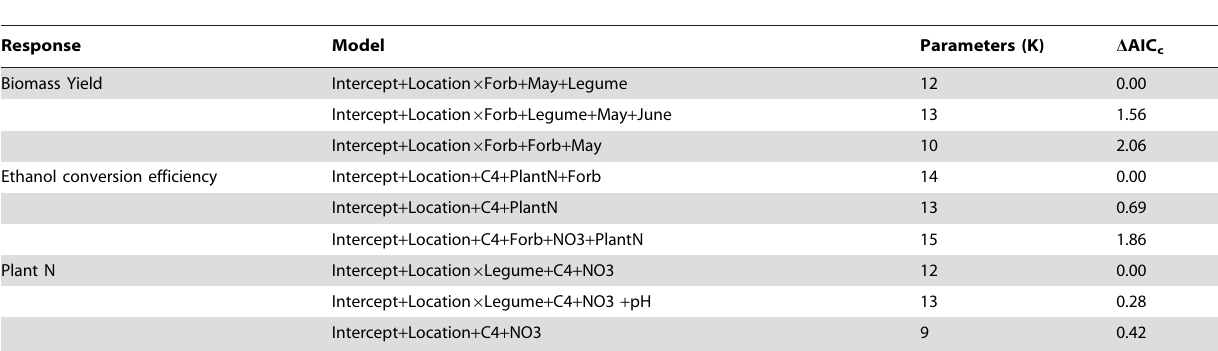
Table 4. Top three best-supported models of bioenergy potential measured from conservation grasslands in Minnesota, USA.